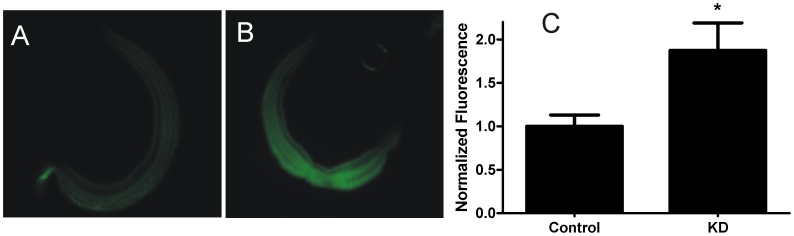
Suppression of S. mansoni ABC transporter expression in adult males increases retention of (R)-PZQ-BODIPY.Adult schistosomes were electroporated with siRNAs targeting luciferase (Control) or the S. mansoni ABC transporters SMDR2, SmMRP1, ABCA4, and ABCB6 (KD), as described in Fig. 6. Males were then exposed to 1 µM (R)-PZQ-BODIPY overnight. (A) Control worm electroporated with luciferase siRNA. (B) Worm electroporated with siRNAs targeting the ABC transporters. Both images were acquired with identical exposures and magnifications. (C) Normalized integrated fluorescence intensity for whole worms. Integrated intensity of fluorescence was quantified by designating the entire worm as the region of interest and subtracting mean background intensity, as described [80]. n = 5 worms for each condition. * indicates P<0.05, two-tailed t-test.